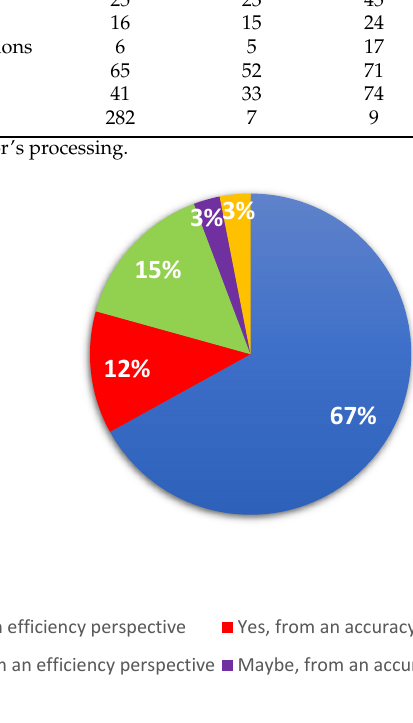
Figure 2. Drones’ utility in improving the field of activity. Source: Author’s processing.